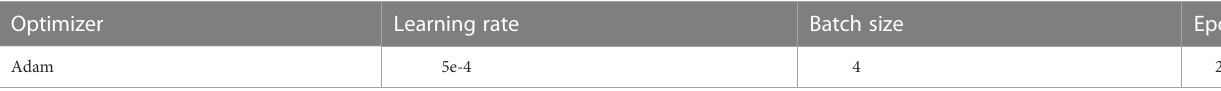
TABLE 1 The parameter setting in training from